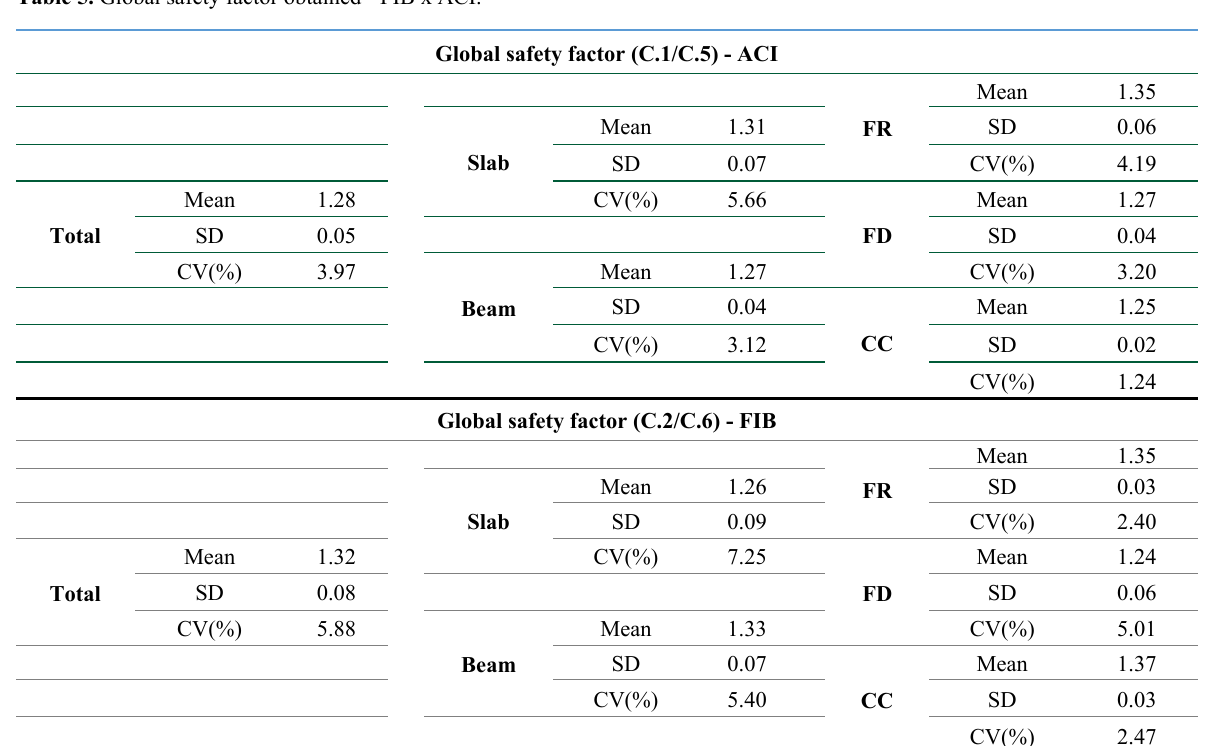
Table 5. Global safety factor obtained - FIB x